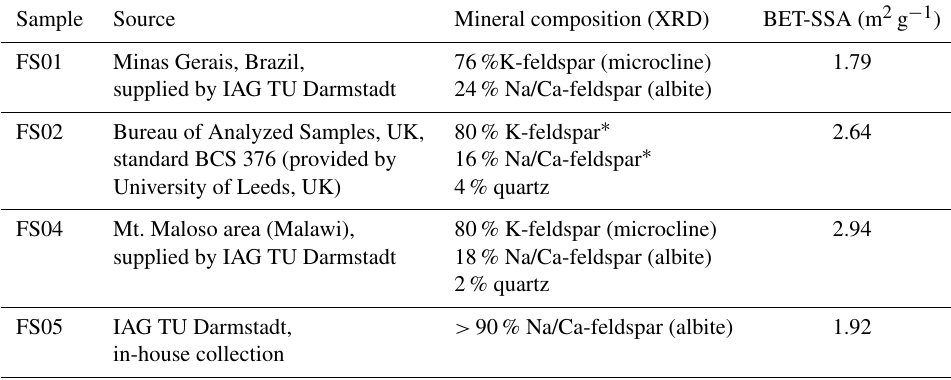
Table 1. The mineral composition and specific surface area (N 2 BET-SSA) of feldspar samples. Sample Source Mineral composition